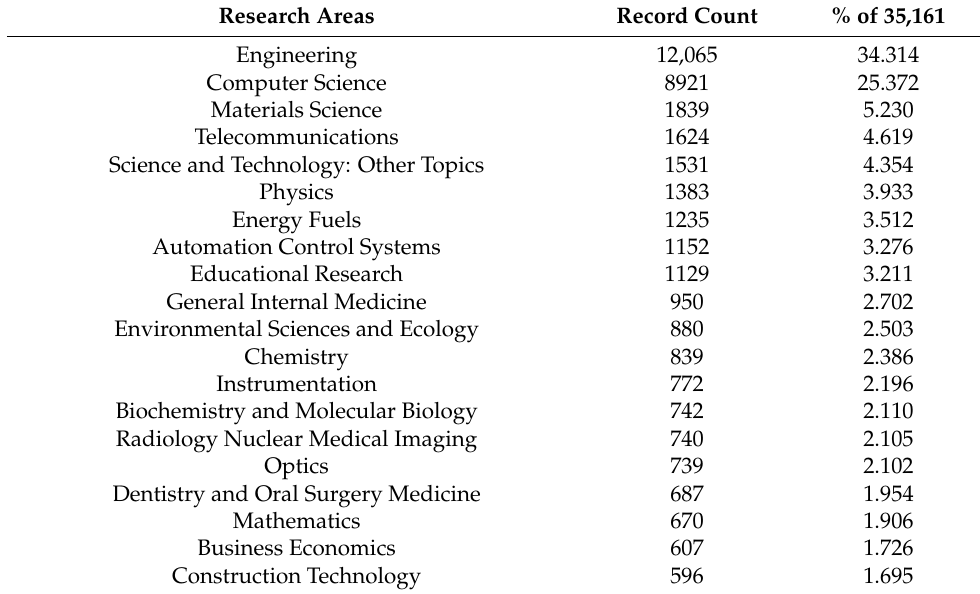
Table 7. Top 20 Research Areas based upon record count of the publications (2016–2018).